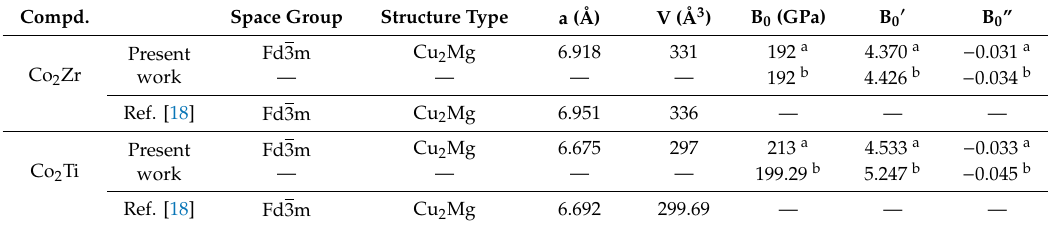
Table 1. The structure parameters of Co 2 Zr and Co 2 Ti at 0 GPa and 0 K.